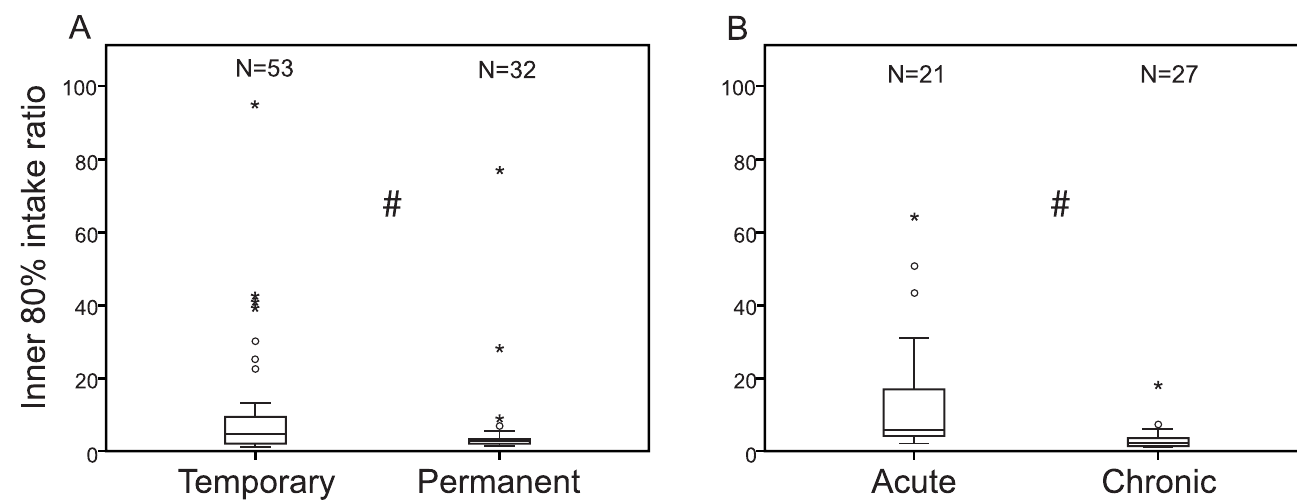
Fig 2. Inner 80% intake ratios of caged honey bees from temporary, permanent, acute and chronic feeding regimes. A . Inner 80% intake ratios (ratio of second highest quantity ingested to that of the second lowest quantity ingested)for pooleddata from all replicates of temporary 1 and permanent 3 feedingof 14 C-labelledsugar solution. B . Inner 80% intake ratios for pooleddata from all replicates of acute 2 and chronic 4 feedingof 14 C- labelledsugar solutionspiked with imidacloprid. # indicatesdifferencesat p < 0.05, Mann-Whitney U-test. ˚ indicatesoutliers (valuesbetween1.5 and 3 times the interquartile range) and * indicatesfar outliers (more than 3 times the interquartile